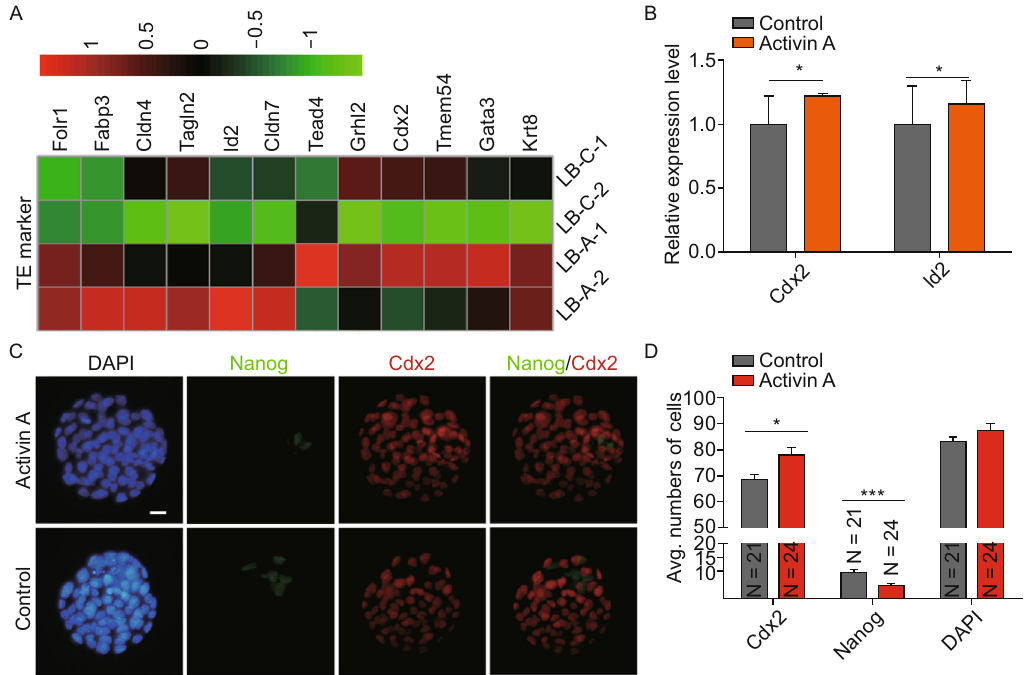
Figure 5. Activin A promotes TE lineage. (A) Heatmap of selected genes related to TE lineage. Heatmap was plotted with Z-score normalized RPKM. (B) Quantitative RT-PCR analyzed the expression of genes selected by heatmap of TE Markers. Error bars indicate SD ( n = 3). * P < 0.05 by Student ’ s t -test. (C) Cdx2 immunostaining in Activin A-treated and untreated embryos at E4.5. Nuclei were stained with DAPI (Blue). Scale bars, 20 μ m. (D) Average numbers of TE cells (Cdx2-positive cells) and EPI (Nanog-positive cells) in Activin A-treated and untreated embryos at E4.5. Error bars indicate SD. * P < 0.05, *** P < 0.001 by ANOVA. N is the number of embryos examined.